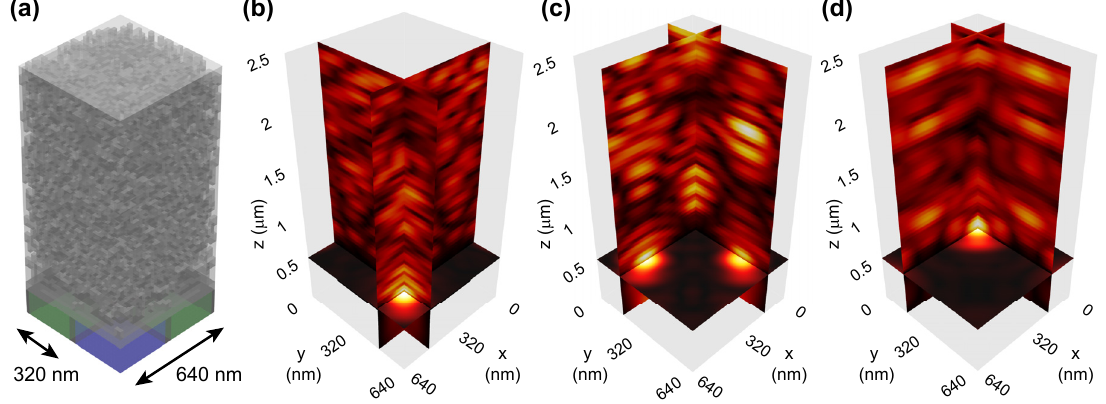
Figure 2: Subwavelength Bayer RGB color router with perfect optical efficiency. (a) Optimized RGB color router for image sensor pixels with 320 nm pixel pitch and a subwavelength device size of 640 nm. Dark and light cubes represent design elements made of titanium dioxide ( ε = 7) and silica ( ε = 2.1), respectively. (b) – (d) Three-dimensional electric fi eld distributions for the B, G – G, and R color channels at the operating wavelengths of 450, 550, and 650 nm,